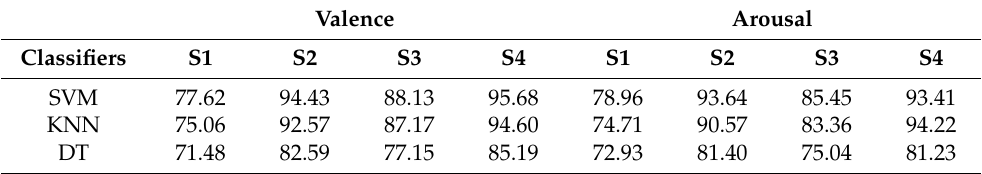
Table 2. Comparison of average sentiment recognition rates (%) on different scenarios.